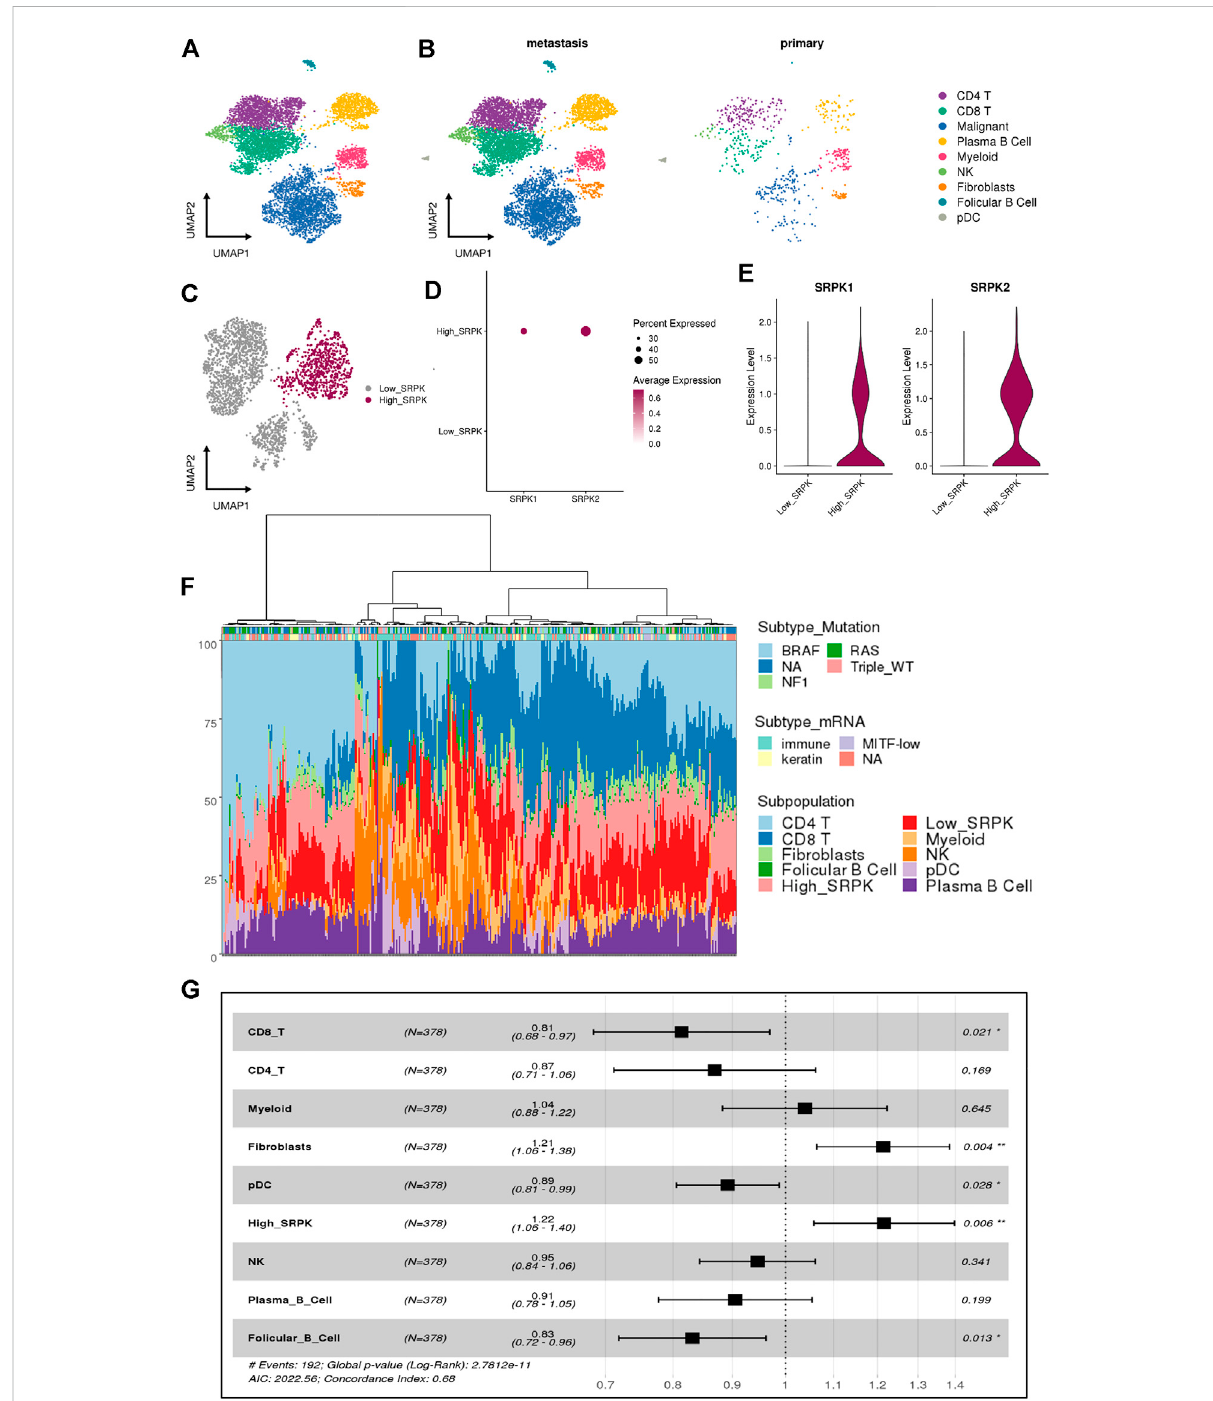
Single-cellRNAsequencingrevealsarelationshipbetweenhighSRPK1/2expressioninmalignantcellsandpoorclinicaloutcomesinmelanoma patients. (A) Analysisof6,696 singlecellsfrommelanomasamples.EachcellisdepictedintheUMAPandcolor-codedforbroadcelltypes. (B) UMAP and color-coded for broad cell types and split by tumor sites. (C) Clusters of malignant cells showing the segregation by High_ and Low_SRPK malignant cells represented in the UMAP. (D) Dot plot and (E) violin plot showing the expression of SRPK1 and SRPK2 among malignant High_SRPK and Low_SRPK cells. (F) Bar plot of the estimated cellular composition in the melanoma TME from the TCGA patient cohort. (G) Forest plot representing the survival hazard ratio of relative fractions, divided into quartiles, for each cell type in a multivariate analysis ( p < 0.001, HR = 1.4, 95% CI = 1.2 –